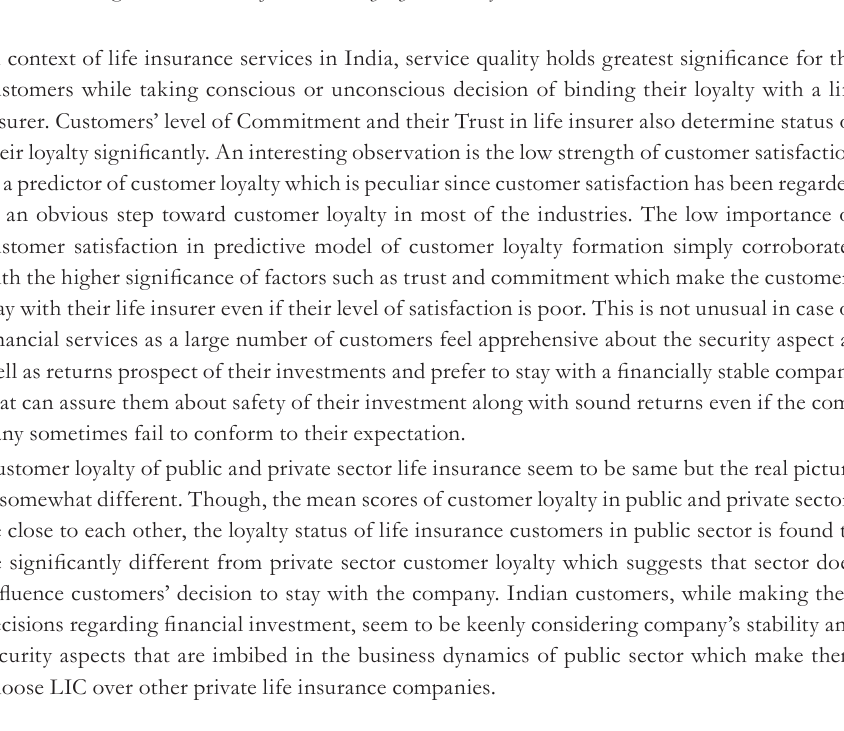
Fig. 6 - Antecedents of Customer Loyalty: A Classification. Source: own